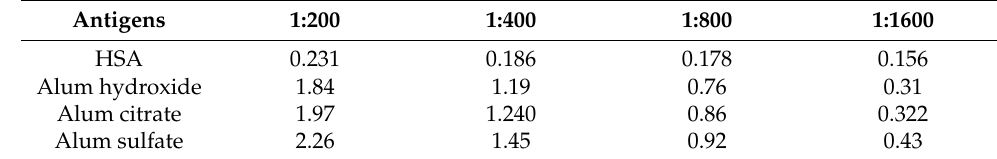
Table 2. Reaction of serially diluted sera with HSA and aluminum-coated ELISA plates.